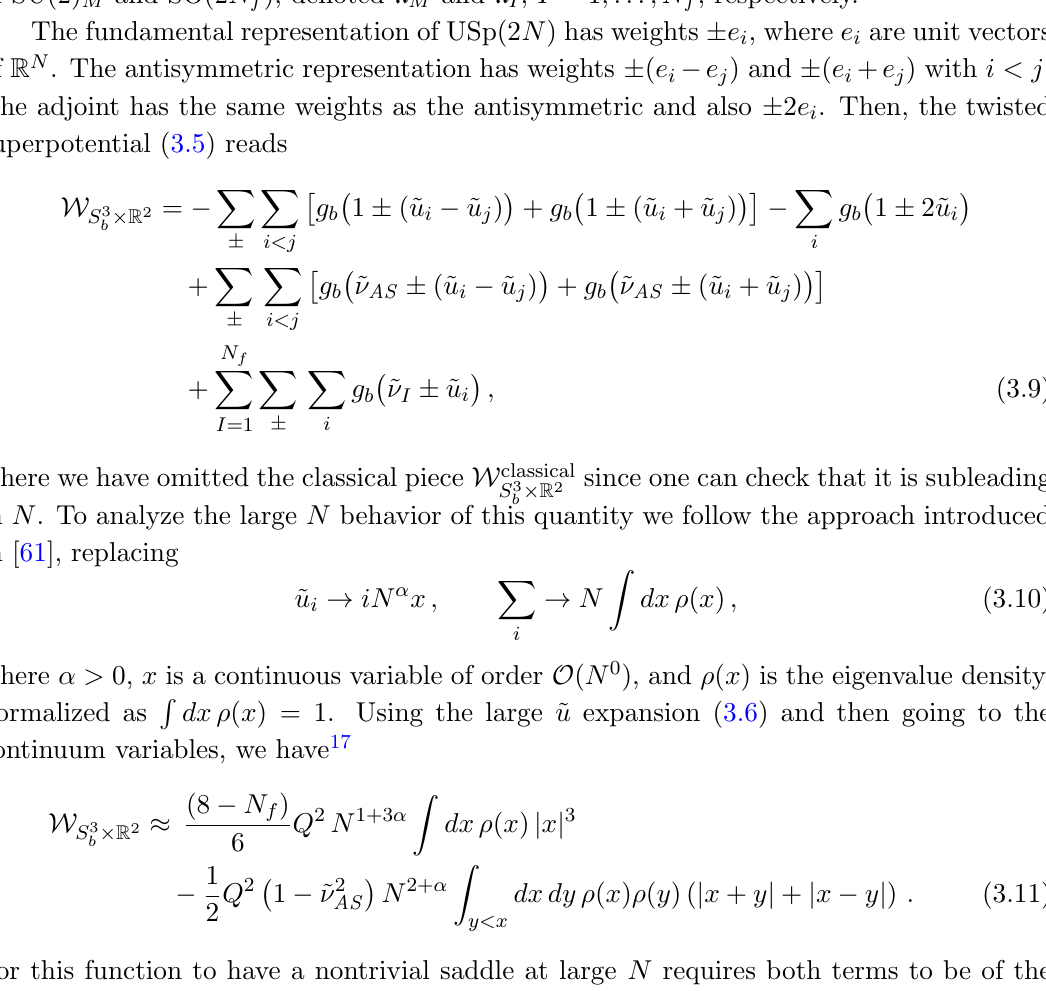
N f Figure 1 . The 5d Seiberg theory. The node represents a USp(2 N ) gauge group, the solid line N f hypermultiplets in the fundamental representation and the dashed line an antisymmet- ric